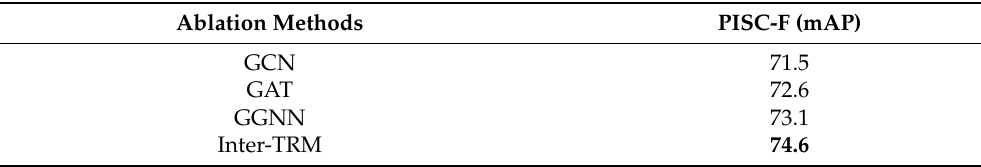
Table 7. Comparative results between Inter-TRM and other graph-based networks on PISC-F. The best results are given in